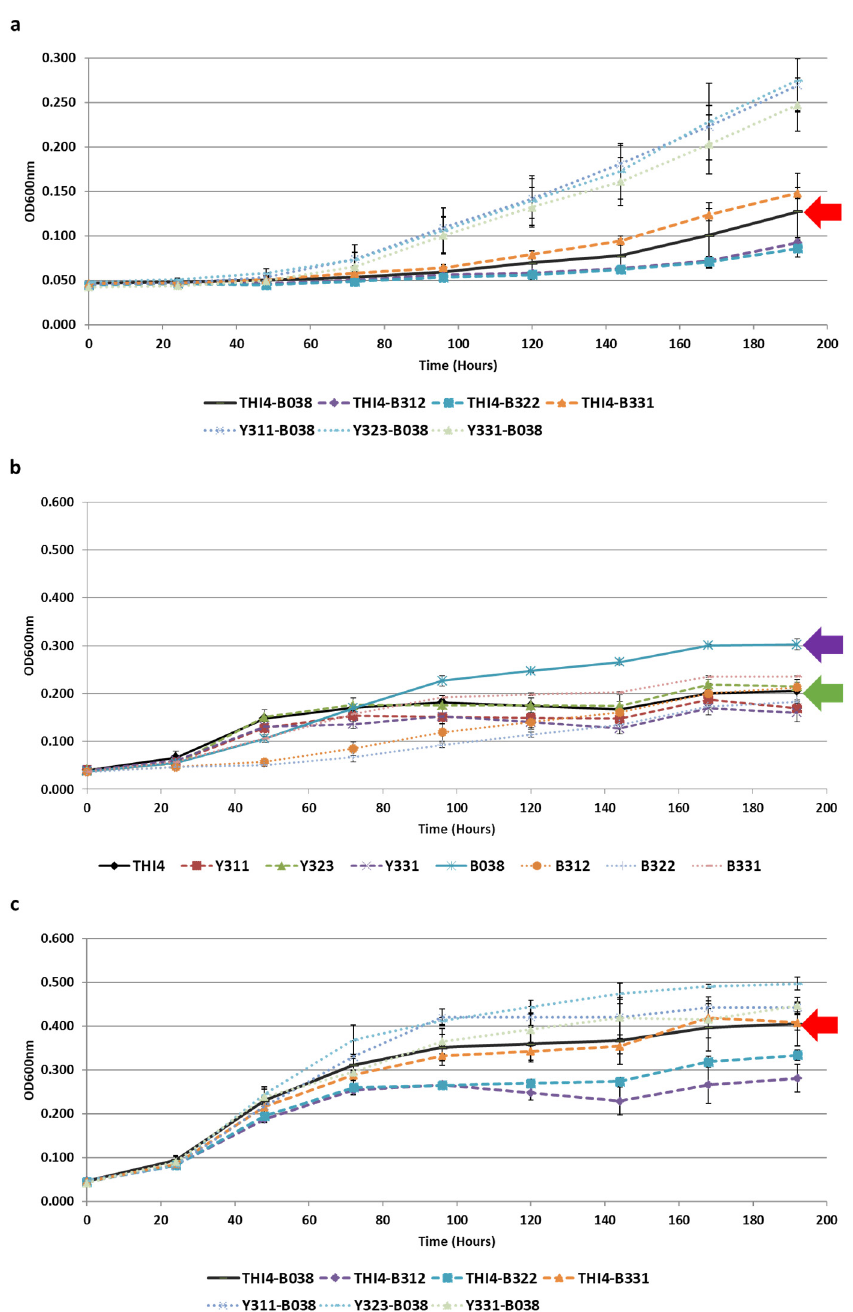
Figure 5. Growth of S. cerevisiae BY4742 ∆ thi4 and Lb. plantarum IWBT B038 evolved isolates in the absence of lysine and isoleucine ( a ) and presence of all amino acids ( b , c ). ( a , c ) The paired growth of the isolates and ( b ) the growth of each isolate in monoculture. Red arrows show the growth of the unevolved parental pairing THI4-B038 ( a , c ) and the purple and green arrows show the growth of the parental bacterial and yeast strains, respectively ( b ). Data shown are means of triplicates, with error bars representing standard deviation.